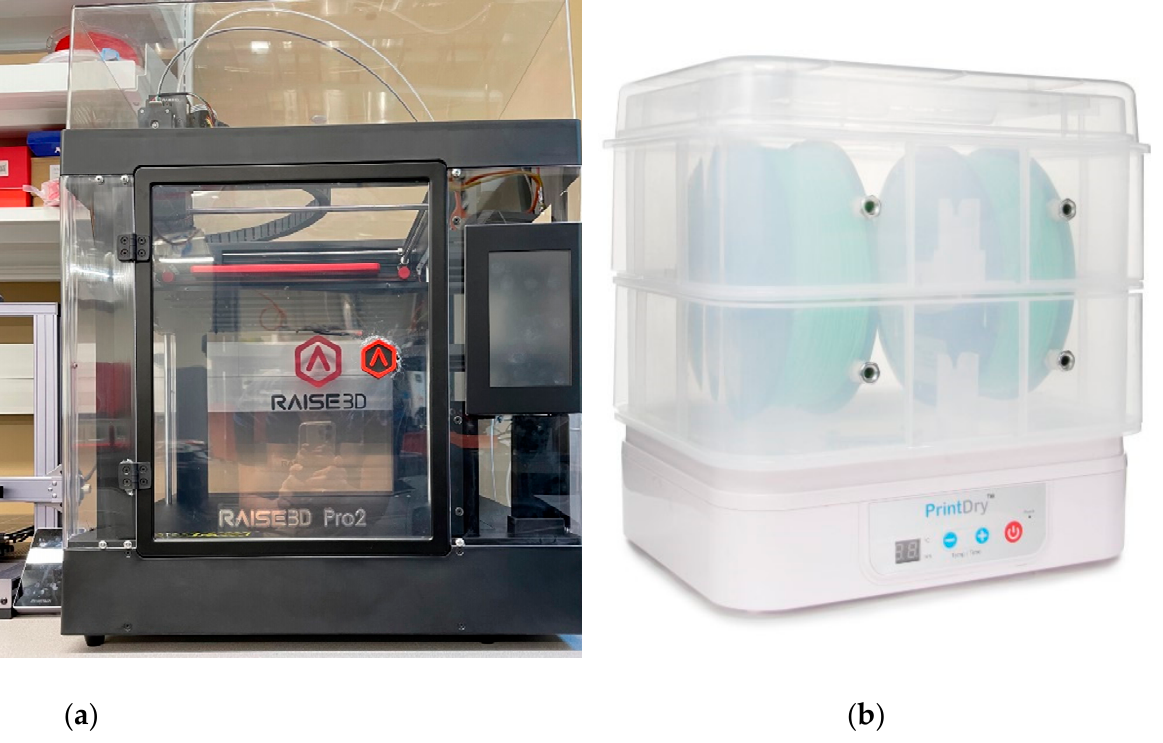
Figure 2. ( a ) Raise3D Pro2 3D printer was used to fabricate all structures. ( b ) PrintDry Pro was used to prevent moisture in structures.